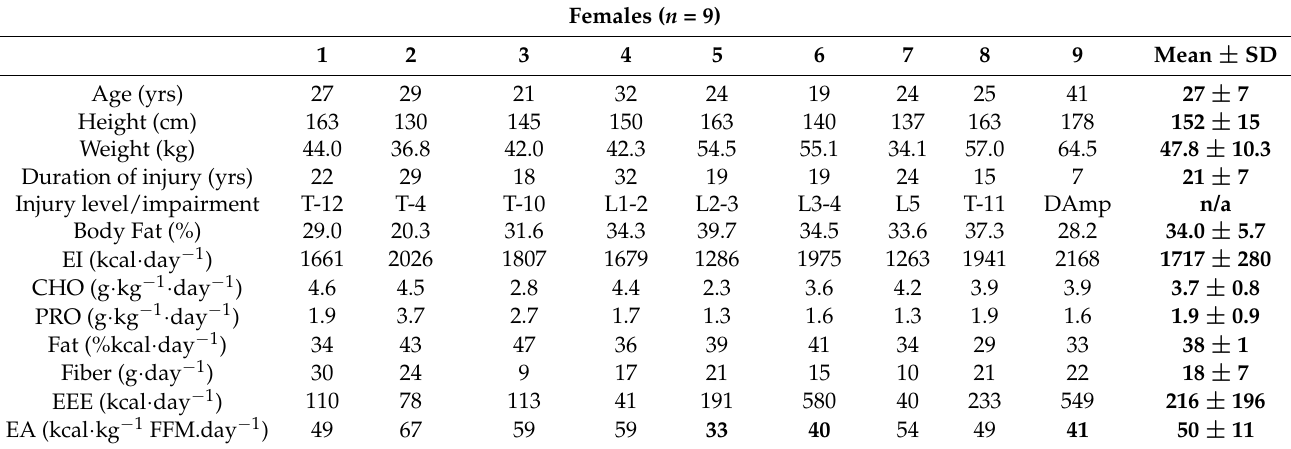
Table 2. Participant ( n = 18) descriptive characteristics and dietary and training